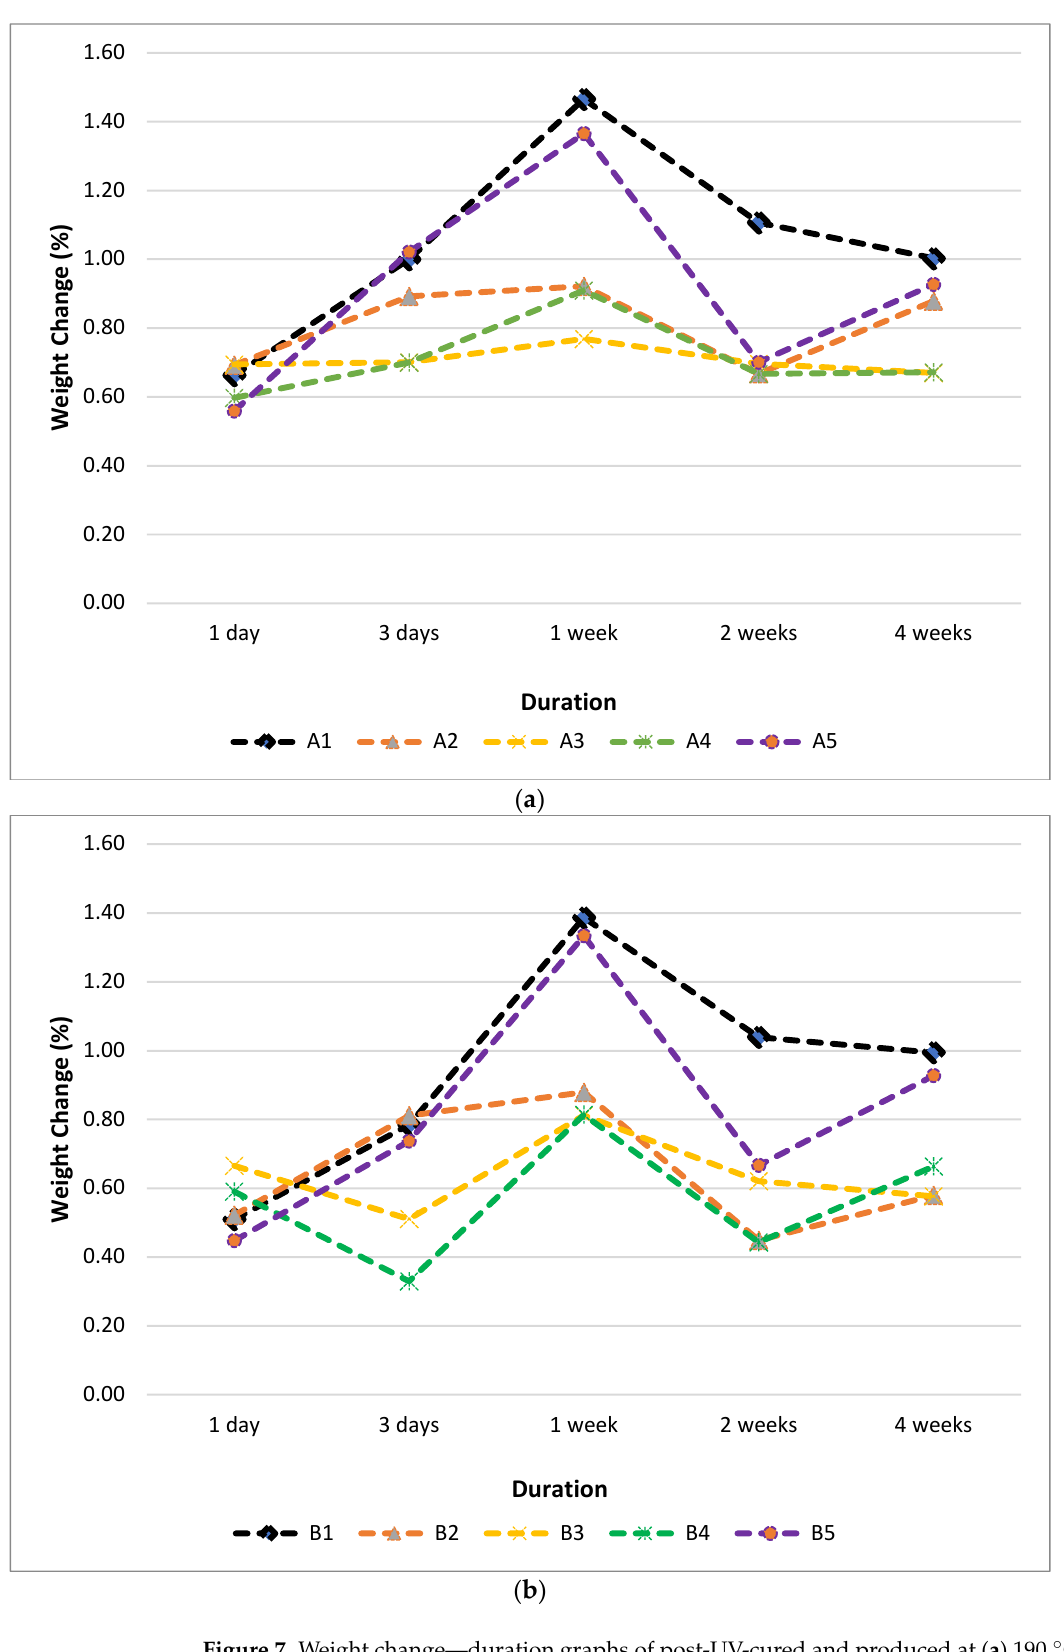
Figure 7. Weight change—duration graphs of post-UV-cured and produced at ( a ) 190 °C ( b ) 200 °C PLA parts.